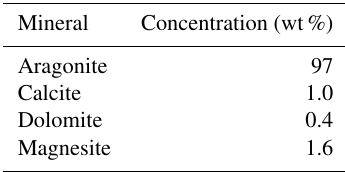
Table A4. Mineral concentrations of coral used in the leaching